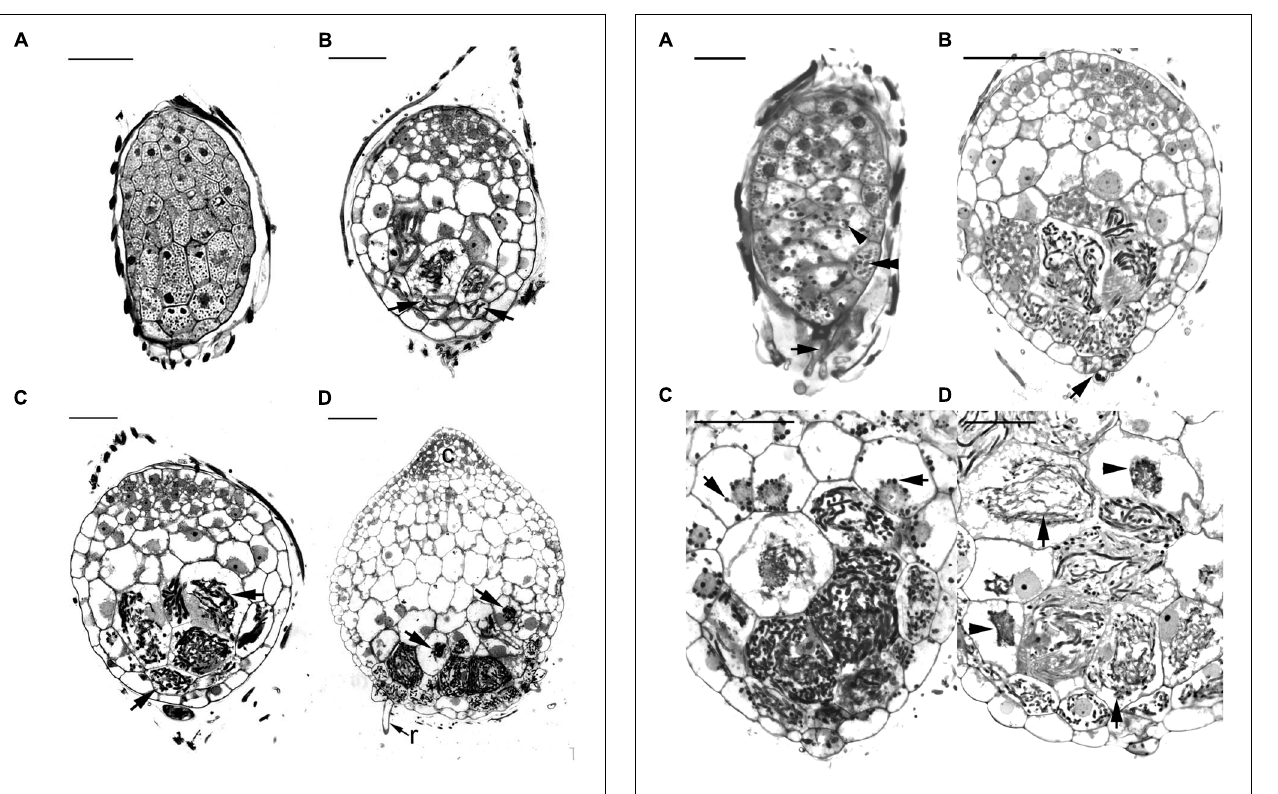
FIGURE 3 | Longitudinal sections of developing protocorms from symbiotic cultures showing the cells with the development and degeneration of fungal hyphae. (A) In the first week of inoculation, the embryo has become slightly swollen, and the fungal hyphae (arrow) have just touched the suspensor end of embryo. Within the embryo cells, the protein bodies are degenerating (double arrowhead), and the starch grains appear (arrowhead). Scale bar = 50 µ m. (B) Fungal hyphae have penetrated the embryo through the suspensor end (arrow) and colonized the middle and basal cortical cells of the enlarged embryo at stage 1. Scale bar = 50 µ m. (C) In a developing protocorm at stage 2, the peloton hyphae are primarily found in the middle and basal cortical cells. In the infected cortical cells, starch grains were depleted, while in the top portion of the protocorm, chloroplasts had appeared and starch grains (arrows) were noticeable within the cytoplasm. Scale bar = 50 µ m. (D) As the protocorm further grows up (stage3), there are a number of collapsing peloton hyphae (arrows) and degenerated hyphal clumps (arrowheads) in the cortical cells. Scale bar = 50 µ